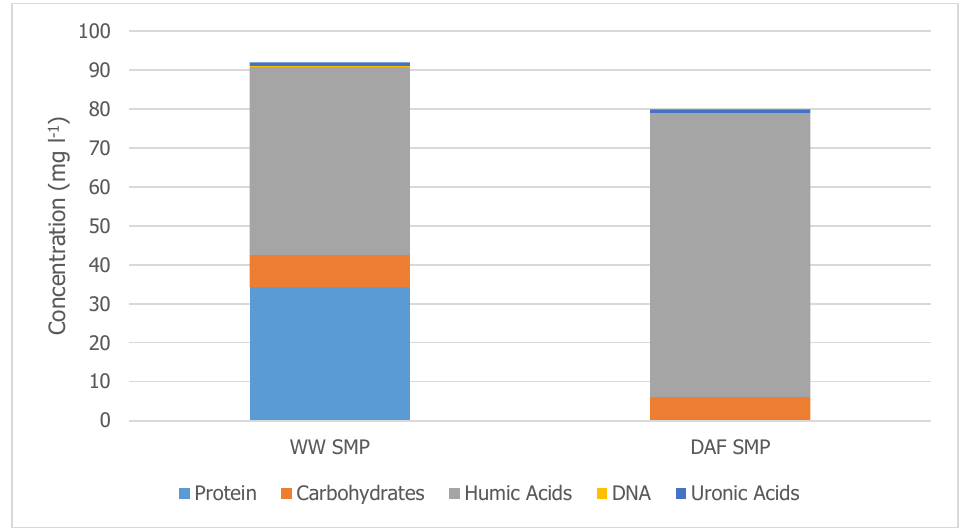
Figure 5. SMP Composition of Raw Wastewater and DAF Underflow (Effluent).